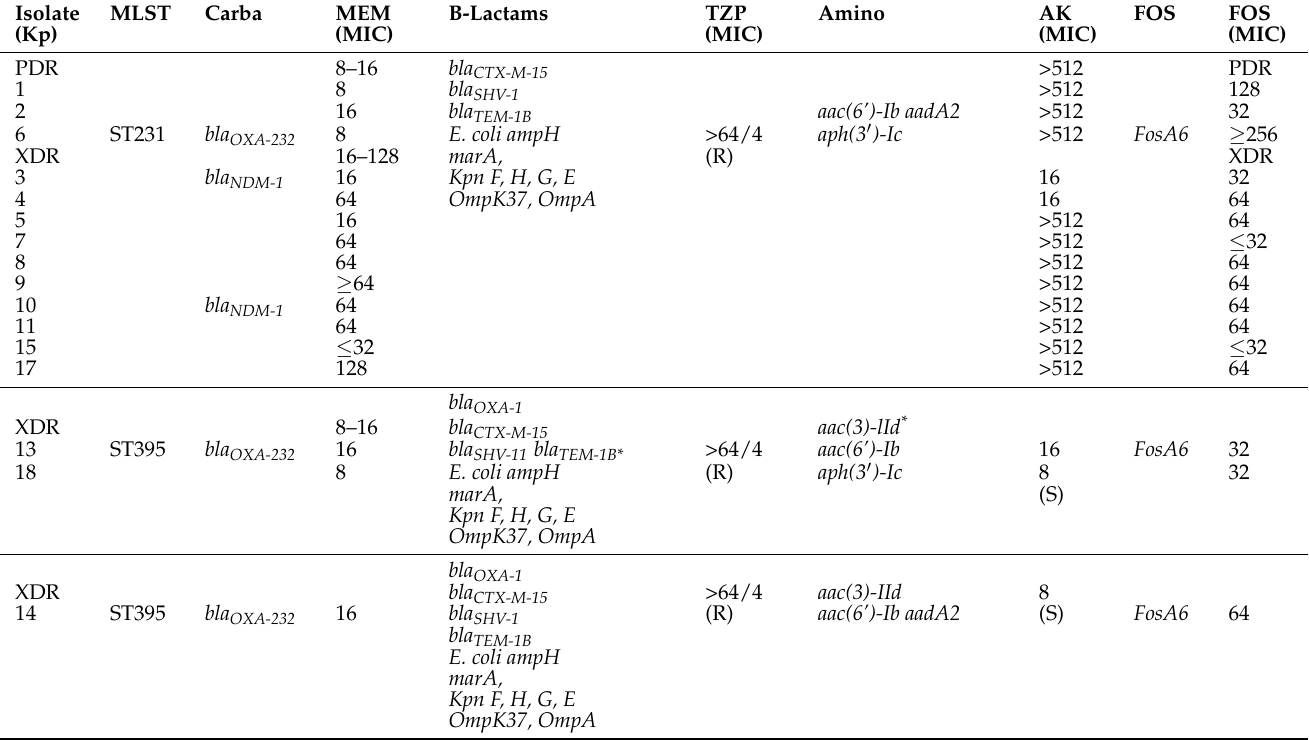
Table 2. The acquired resistance genes to different classes of antimicrobials in K. pneumoniae